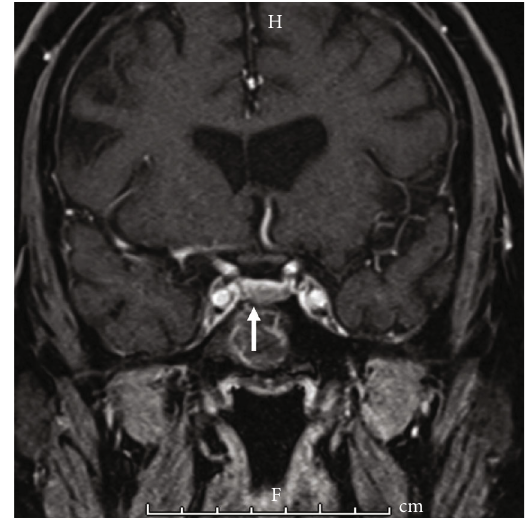
Figure 1: MRI of pituitary microadenoma consistent with Cushing ’ s disease. Coronal T1-weighted enhanced MRI of the pituitary gland shows an anterior inferior pituitary lesion to the right of midline measuring approximately 6 × 6 × 3